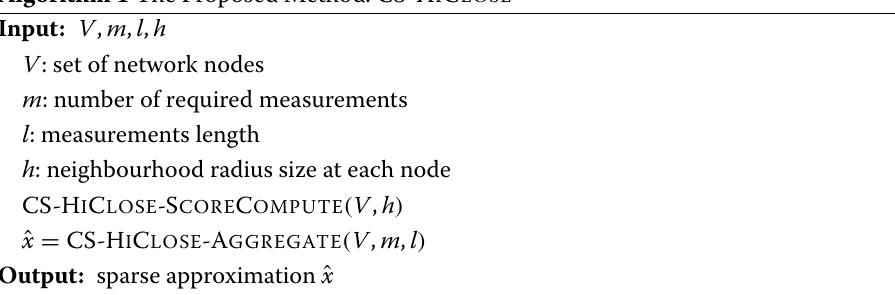
Algorithm 1 The Proposed Method: CS-H I C